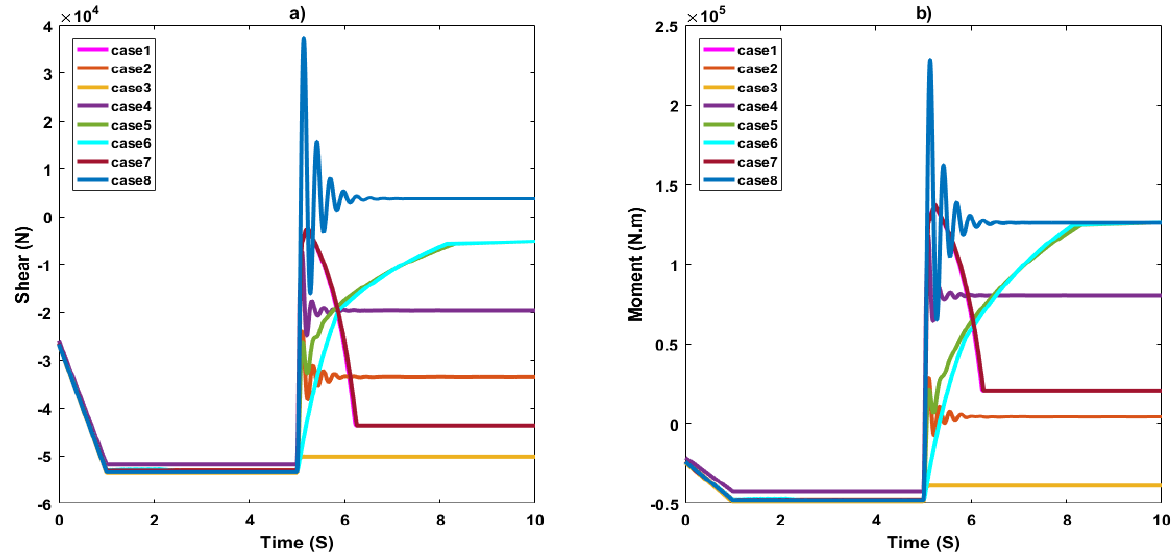
Figure 20. Beam behavior after column removal in story thirteen: ( a ) shear and ( b ) moment. As shown in Table 3, which was compared with the removal of the column on the first floor in case 8, in beam number 118, the highest shear force is related to case 8, and the lowest is related to case 1; however, in the bending moment model is the highest force in case 8 and the lowest is re- lated to case 3. As Figure 19 shows and values are illustrated in Table 4, after removing the col- umn on the 6th floor, the highest shear force is created in case 8, while the lowest is related to case 3. Therefore, the bending moment force is related to case 3. Table 3. Result force story 1 for element 118.